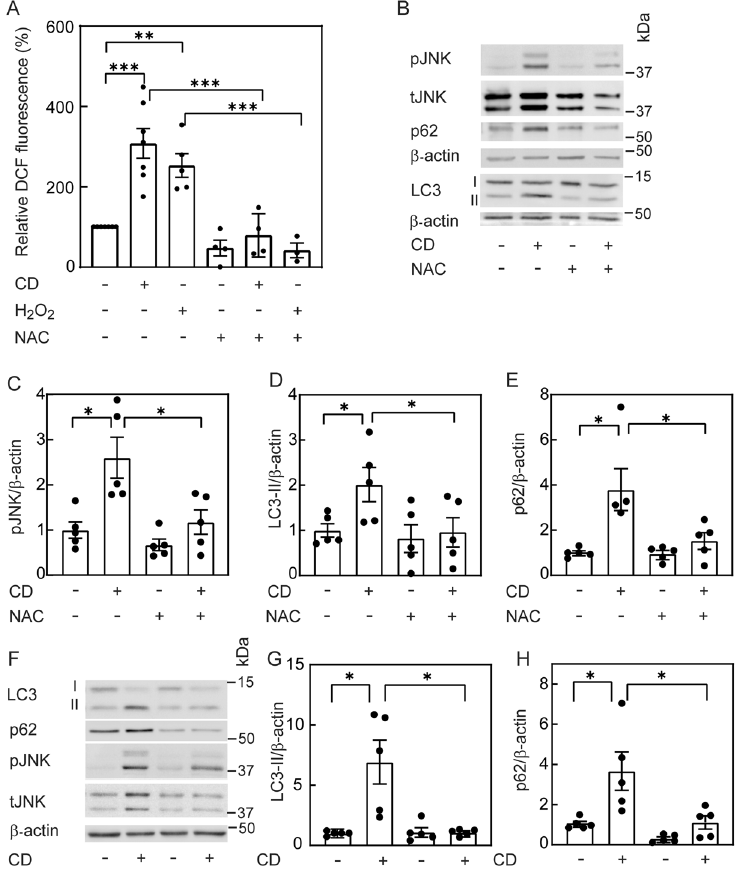
Fig. 6 Elevation of ROS by cholesterol depletion is required for JNK activation and for the effects on LC3-II and p62 levels. Mv1Lu cells in 6-well plates were subjected (or not) to CD by statin (16 h) with or without the ROS scavenger NAC (10 mM; A – E ), or the JNK inhibitor SP600125 (20 μ M; F – H ). A CD elevates ROS. Cells were treated (or not) with H 2 O 2 (0.75 mM, 2 h; positive control), and incubated at 37 °C with DCF (10 μ M, 30 min). After washing, DCF fl uorescence intensity was determined by FACS with excitation at 485 nm and emission at 525 nm, taking the intensity measured in untreated cells in the same experiment as 100%. Bars are mean ± SEM of 3 – 7 independent experiments. Asterisks indicate a signi fi cant difference between the indicated pairs (** P < 0.01; *** P < 0.001; one-way ANOVA and Bonferroni post hoc test). B – E The ROS scavenger NAC prevents the effects of CD on JNK activation and on LC3-II and p62 levels. A representative blot is shown in panel B . Quanti fi cation of the effect of NAC on the levels of the proteins tested is depicted for pJNK ( C ), LC3-II ( D ), and p62 ( E ). The control sample (no CD, no NAC) for each protein was taken as 1. Bars are mean ± SEM of 5 independent experiments (* P < 0.05; Student ’ s two-tailed t -test). F – H Inhibition of JNK ac t ivity prevents the effect of CD on LC3-II and p62 levels. F A representative blot. G , H Quanti fi cation of the effects on LC3-II and p62 protein levels. Bars, mean ± SEM of 5 independent experiments. In each blot, the untreated sample (control) was taken as 1. Asterisks indicate signi fi cant differences between the pairs of samples indicated by the brackets (* P < 0.05; Student ’ s two-tailed t -test).